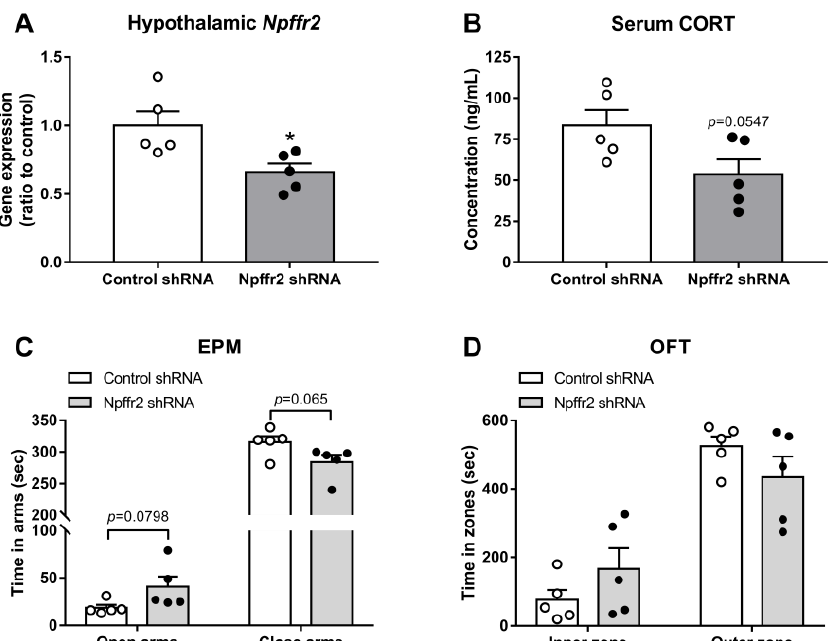
Figure 6. Intra-hypothalamic paraventricular nucleus (PVN) Npffr2 silencing affects behavioral and biochemical endpoints in mice exposed to SPS. Mice were exposed to SPS 1–2 weeks after intra-PVN lenti- Npffr2- shRNA injection. ( A ) The effect of hypothalamic Npffr2 gene knockdown. ( B ) The level of serum CORT after SPS exposure. Anxiety-like behaviors were measured by ( C ) EPM and ( D ) OFT. Data are represented as mean ± SEM and are analyzed by unpaired Student’s t -test. * p < 0.05; comparing control and Npffr2 -shRNA treatment groups ( n = 5 per group). The white and black dots indicate the individual value of WT and NPFFR2 KO mice, respectively.